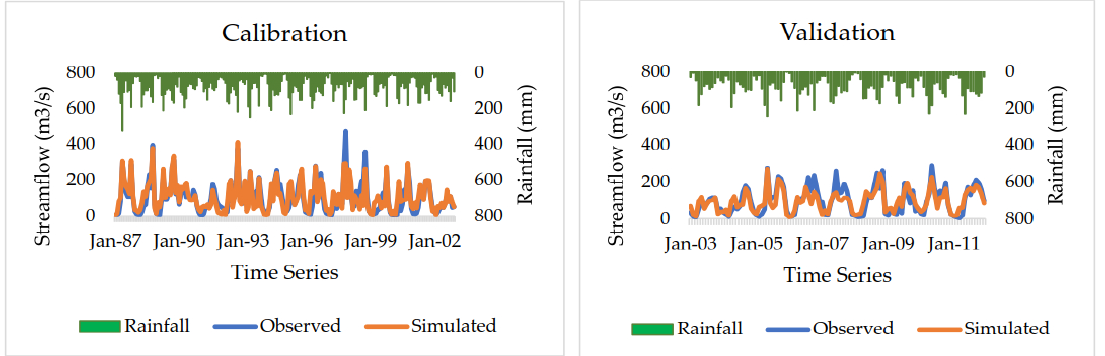
Figure 6. Streamflow hydrograph of observed and simulated model’s calibration and validation.